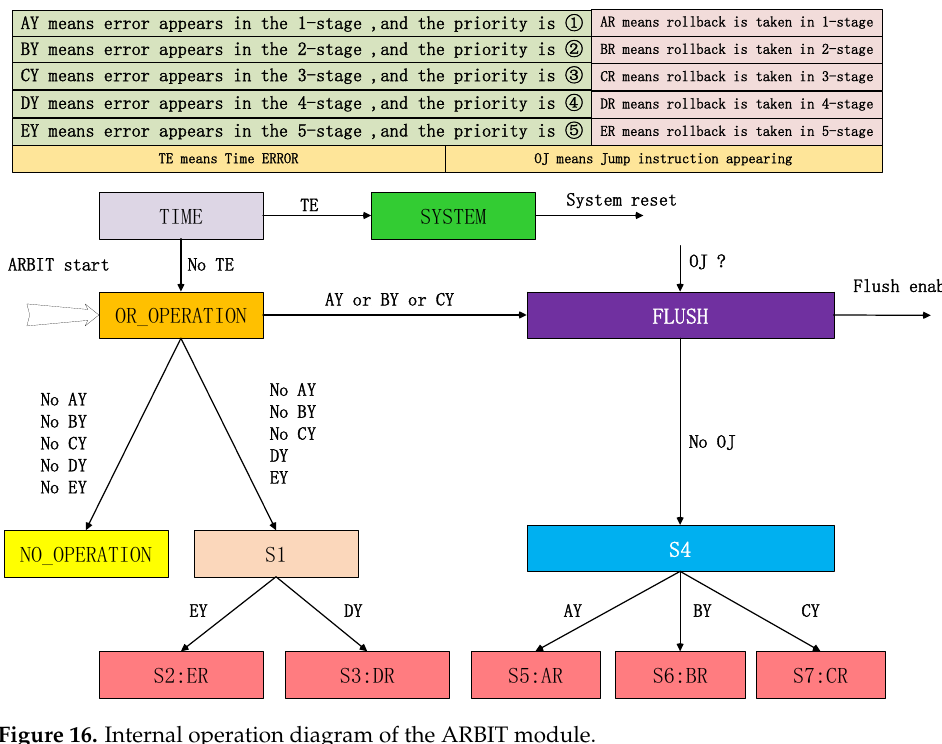
Figure 16. Internal operation diagram of the ARBIT module.